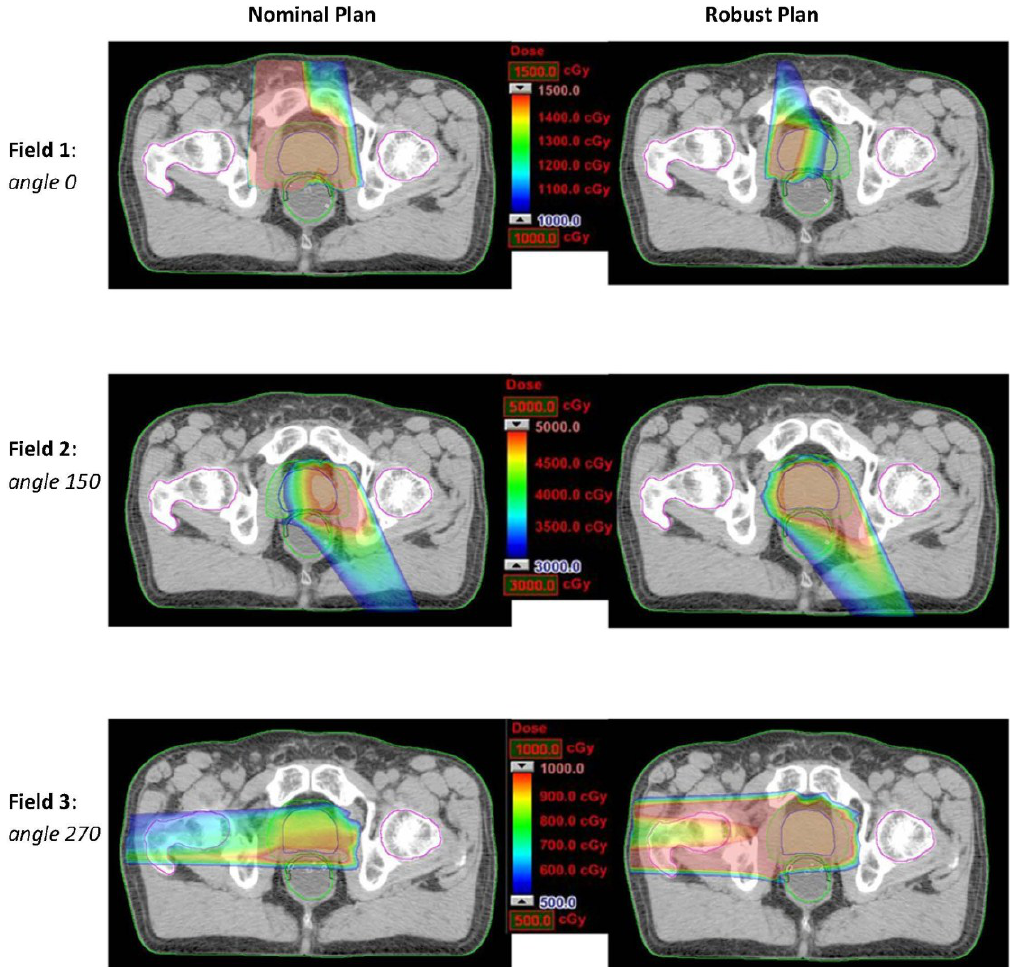
Figure 3. Dose distributions (per field) in the transverse plan for comparing the nominally optimized and robustly optimized three-beam IMPT plan for one prostate cancer patient.